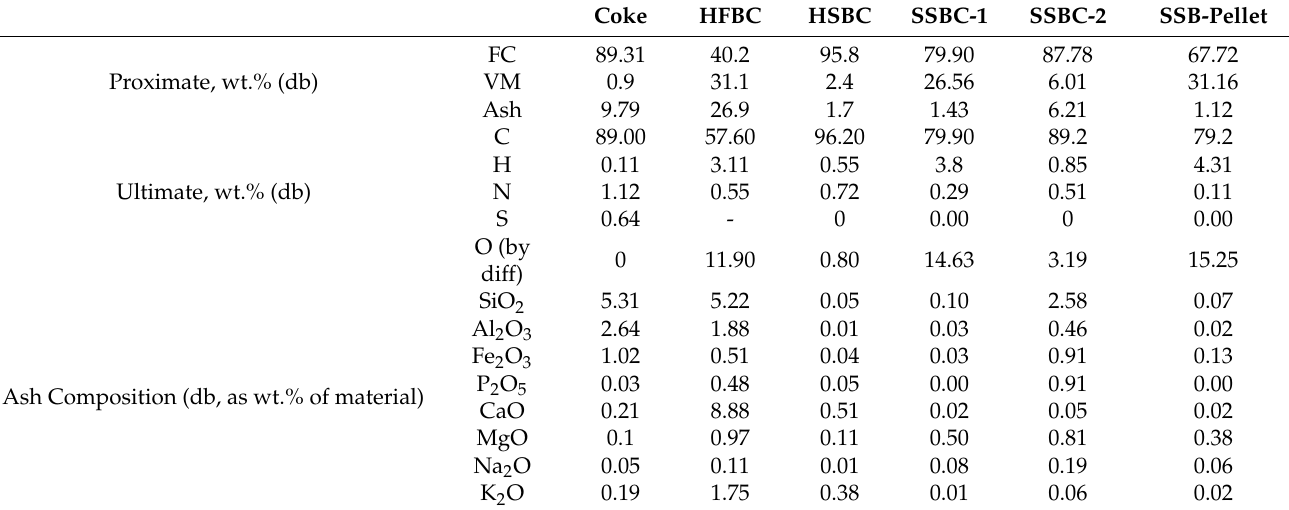
Table 5. Chemical composition of biogenic materials, prior to heating at 900 ◦ C, and coke used for interfacial interactions experiments.